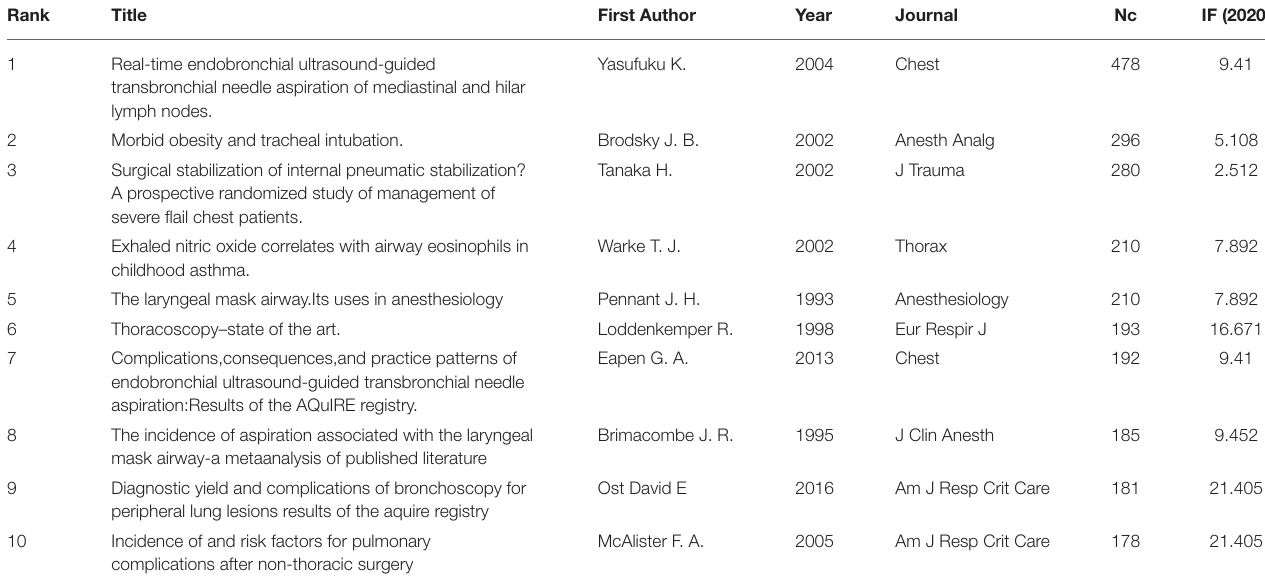
TABLE 2 | The top 10 most active